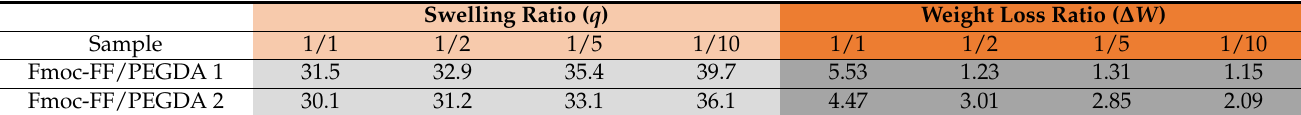
Table 1. Results of swelling and stability tests. The swelling ratio ( q ) and the weight loss ratio ( ∆ W ) was calculated as a percentage according to Equations (1) and (2), respectively. Swelling Ratio ( q